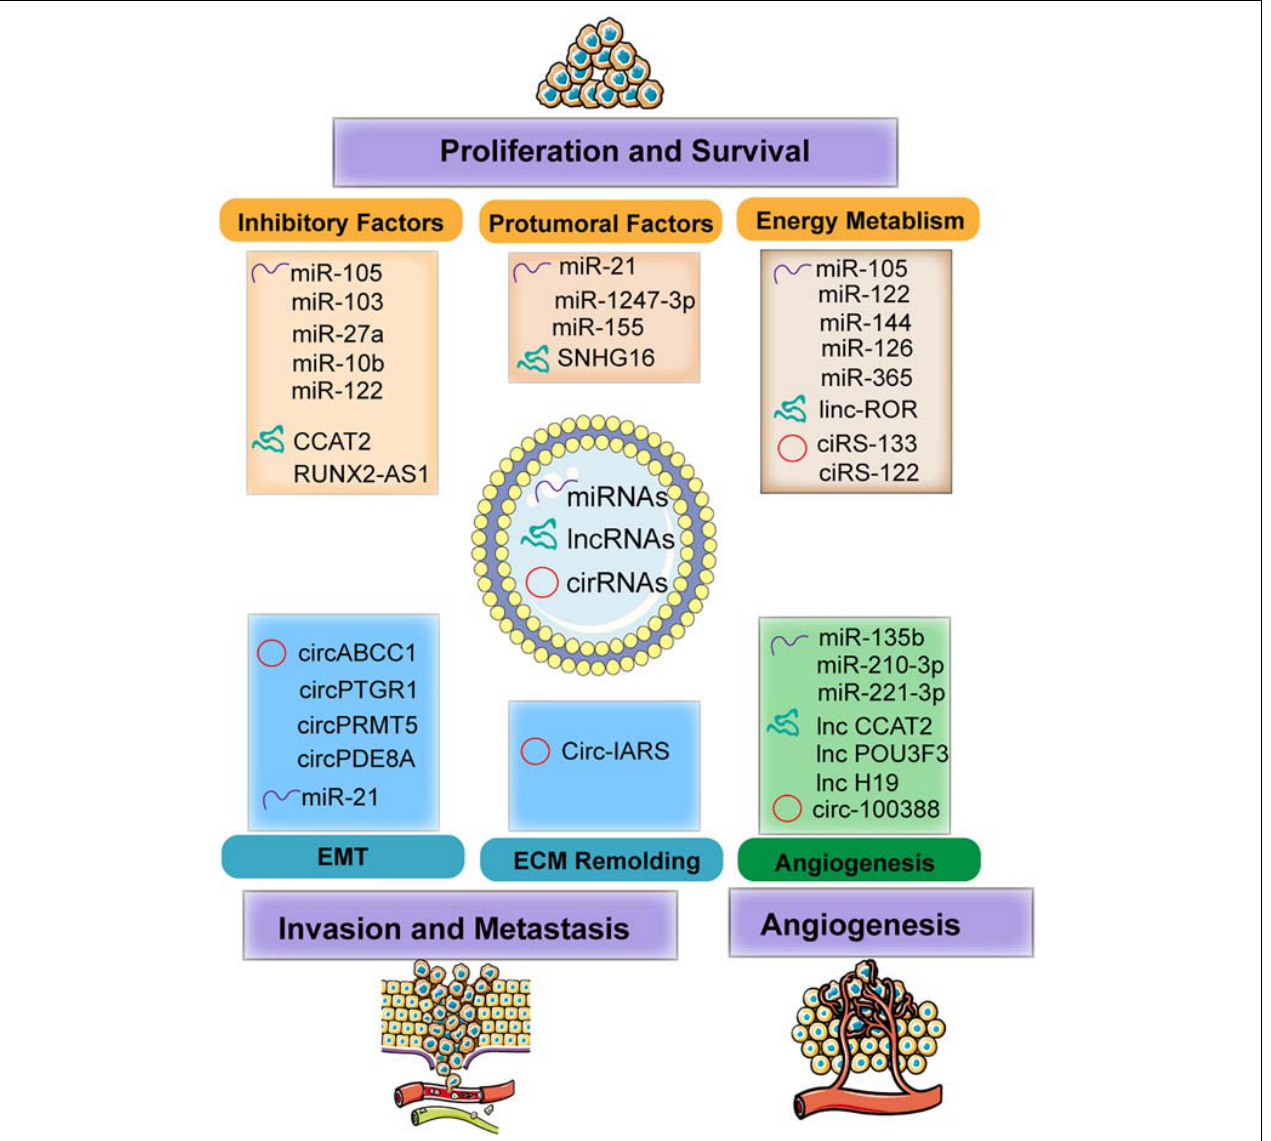
FIGURE 3 | The functions of exosomal non-coding RNAs (ncRNAs) including microRNAs (miRNAs), long non-coding RNAs (lncRNAs), and circular RNAs (circRNAs) modulate the TME in facilitating the tumor progression and metastasis. Specifically, the mechanism involved in molding the TME including regulating energy metabolism (such as glycolysis and oxygen metabolism) and transmitting the protumoral or inhibitory factors to recipient cells. In addition, exosomes transferred to endothelial cells (ECs) induce angiogenesis by regulating the features of ECs. Furthermore, exosomes also mediated invasion and metastasis by epithelial–mesenchymal transition (EMT) and extracellular matrix (ECM)